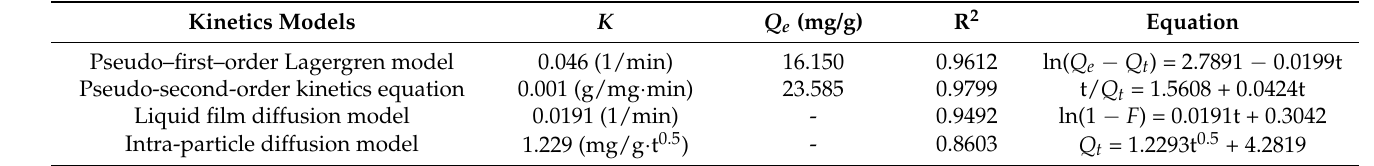
Table 9. The adsorption kinetics model parameters for the adsorption methyl orange onto